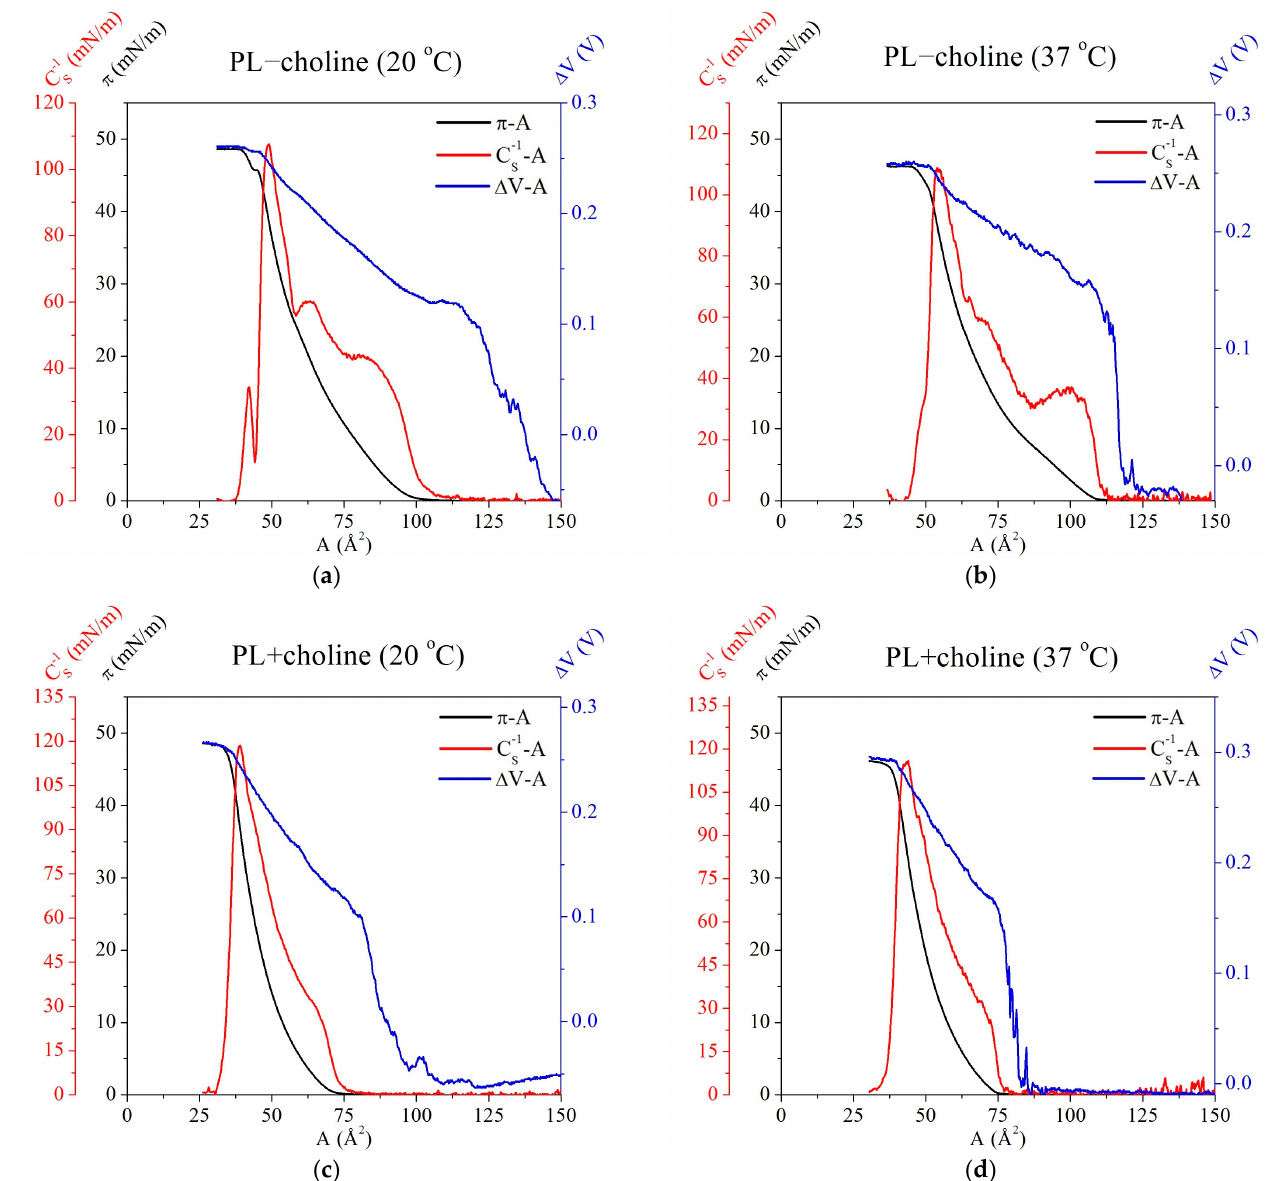
Figure 4. Surface pressure ( π ), compressibility modulus (C − 1 ) and surface potential changes ( ∆ V), vs. the mean molecular area (A) for the obtained monolayers: PL − choline at 20 °C (a), PL − choline at 37 °C (b), PL+choline at 20 °C (c) and PL+choline at 37 °C (d).